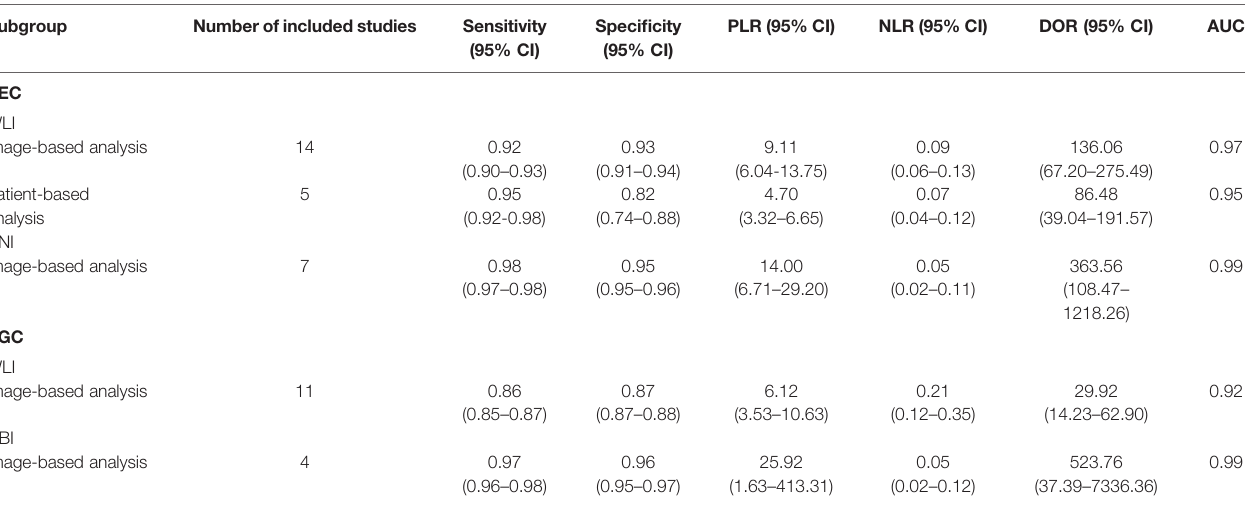
TABLE 2 | Summary of subgroup analysis based on imaging